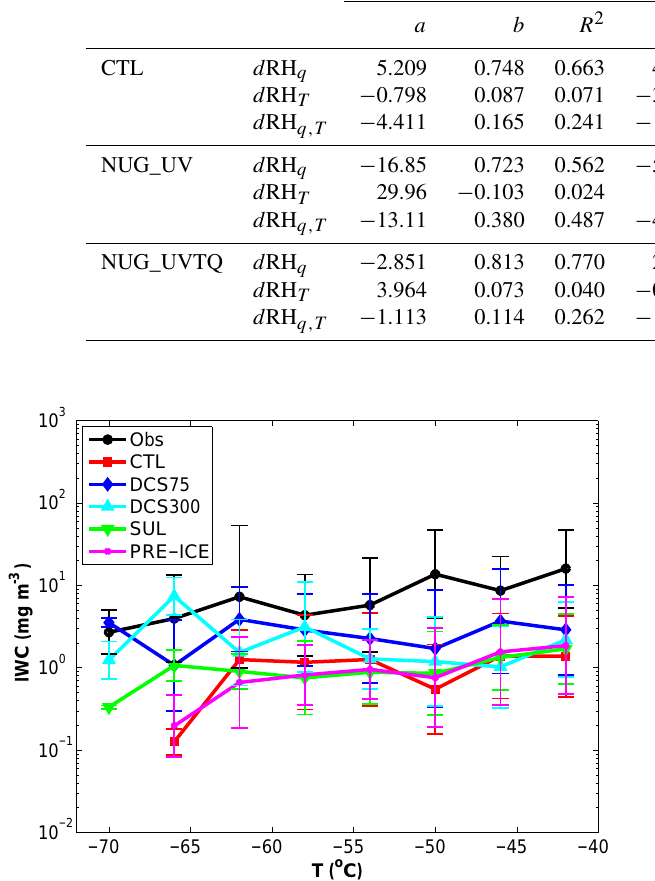
Figure 11. As Fig. 9 but for ice water content (IWC) versus tem-